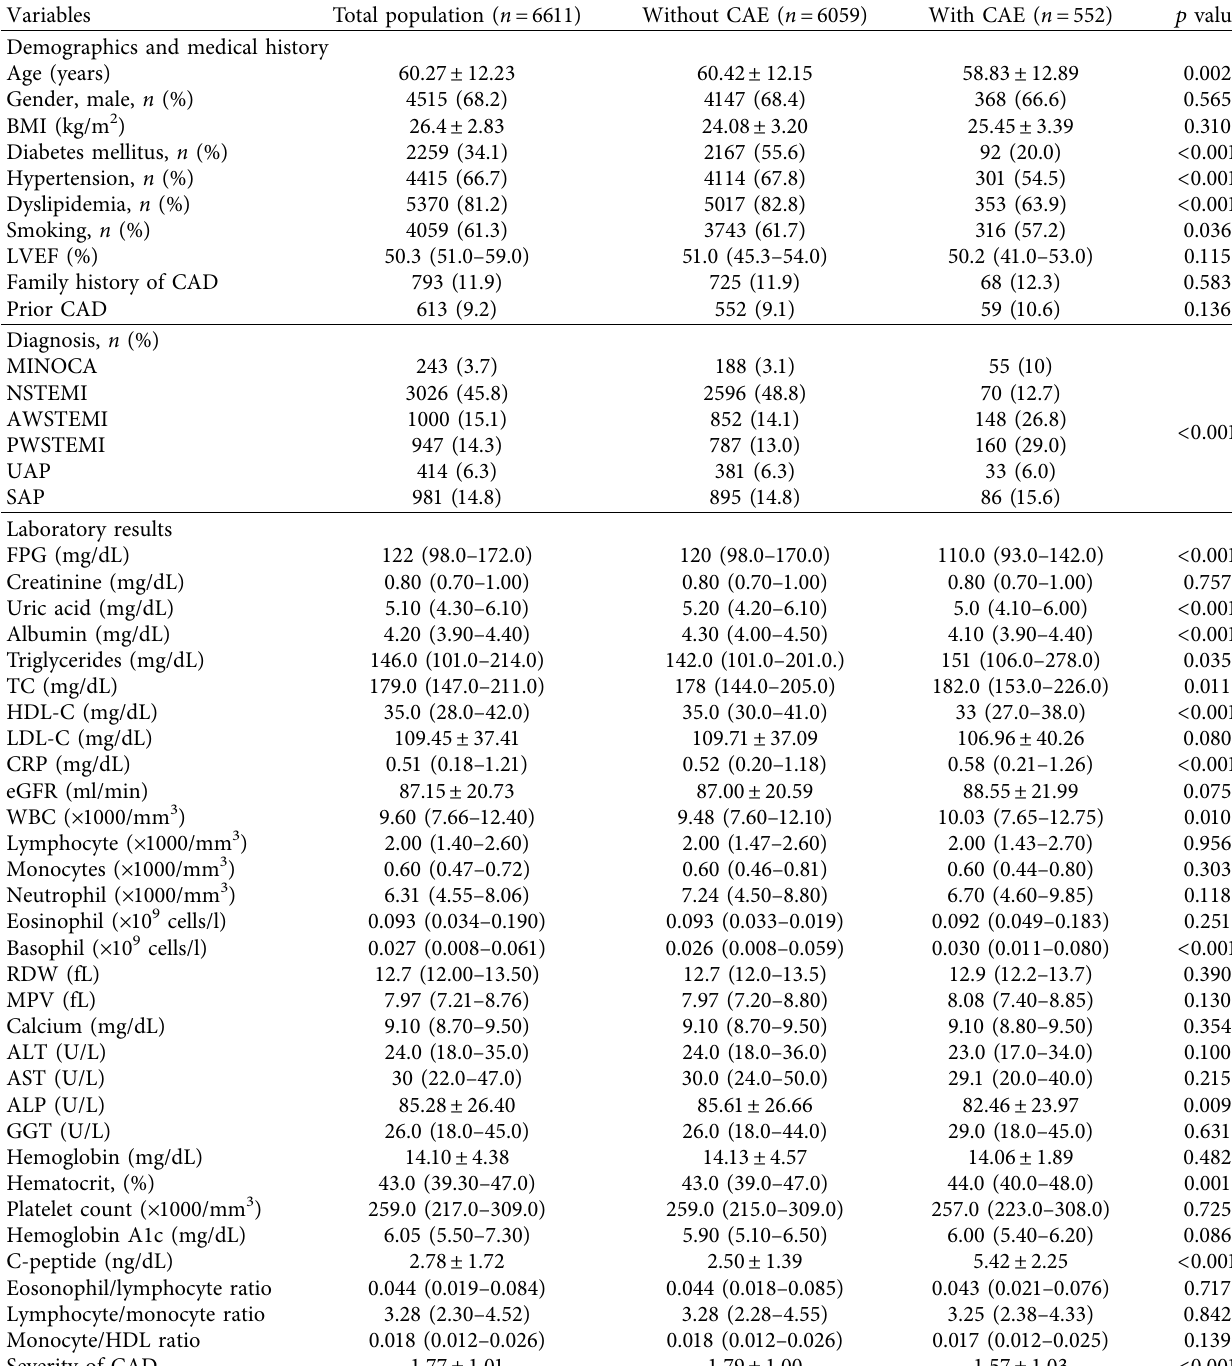
Table 1: Distribution of clinical and demographic characteristics of the patients according to coronary artery